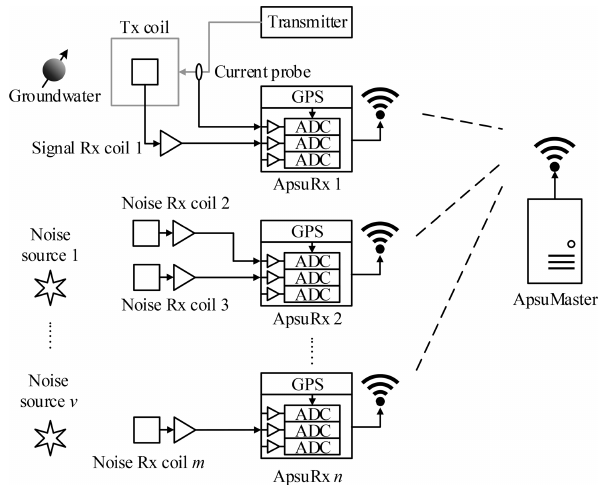
Figure 1. Setup of the wireless multichannel surface-NMR receiver Apsu. Each ApsuRx contains three GPS-synchronized channels. A current probe is connected to a channel of ApsuRx1 detecting the pulse, and signal Rx coil 1 is connected to the other channels record- ing the NMR signal. In the vicinity of noise sources, ApsuRx2– ApsuRx n and noise Rx coil 2–m are deployed.